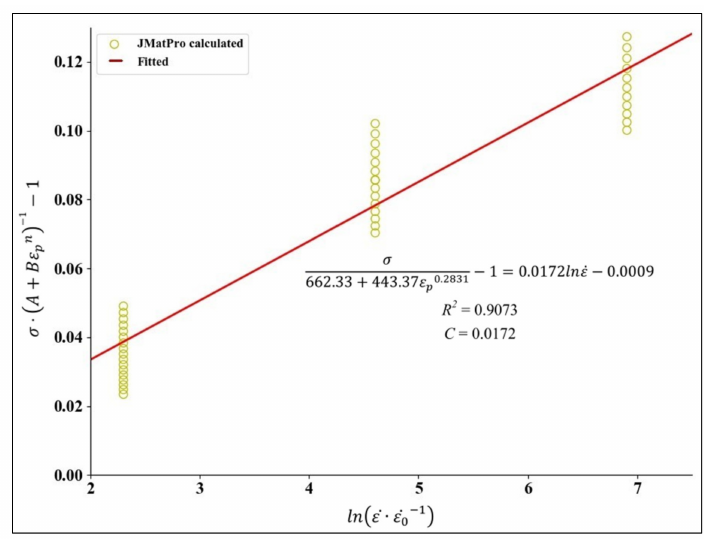
Figure 6. Solutions of three parameters ( A , B and n ).